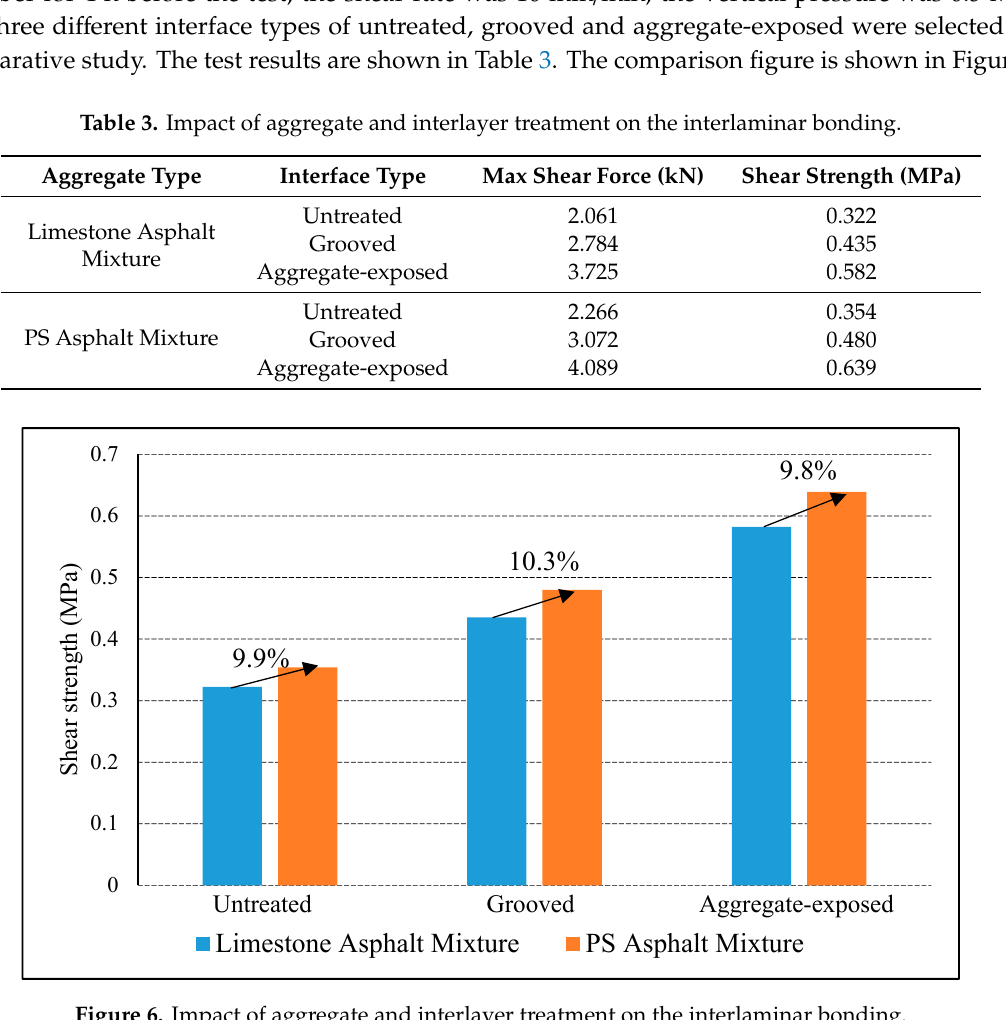
Figure 6. Impact of aggregate and interlayer treatment on the interlaminar bonding.